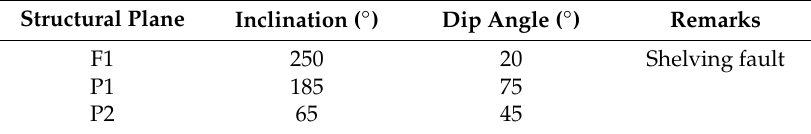
Figure 4. Structural plane diagram of tunnel face. Table 1. Characteristics of the structural plane.